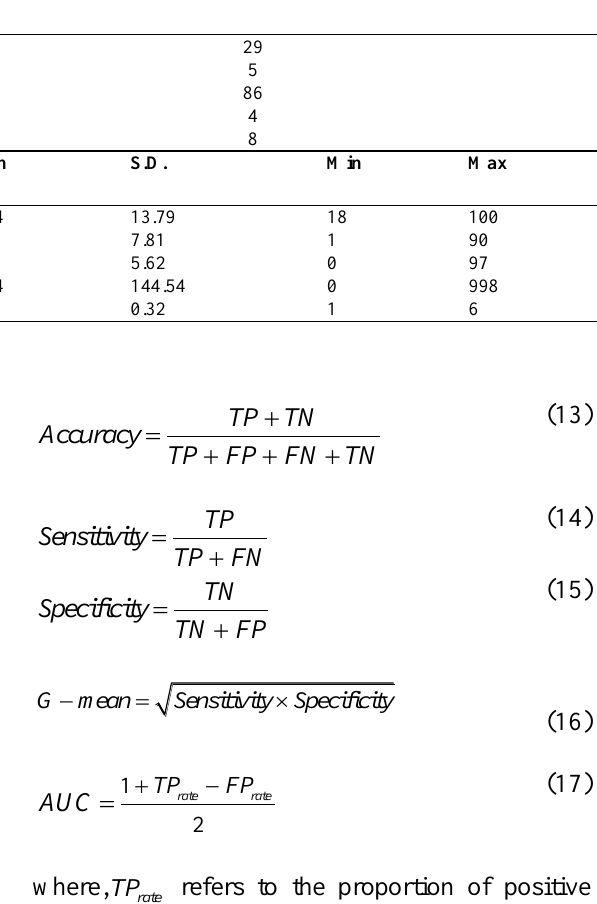
Distinct value variable Categorical Feature number